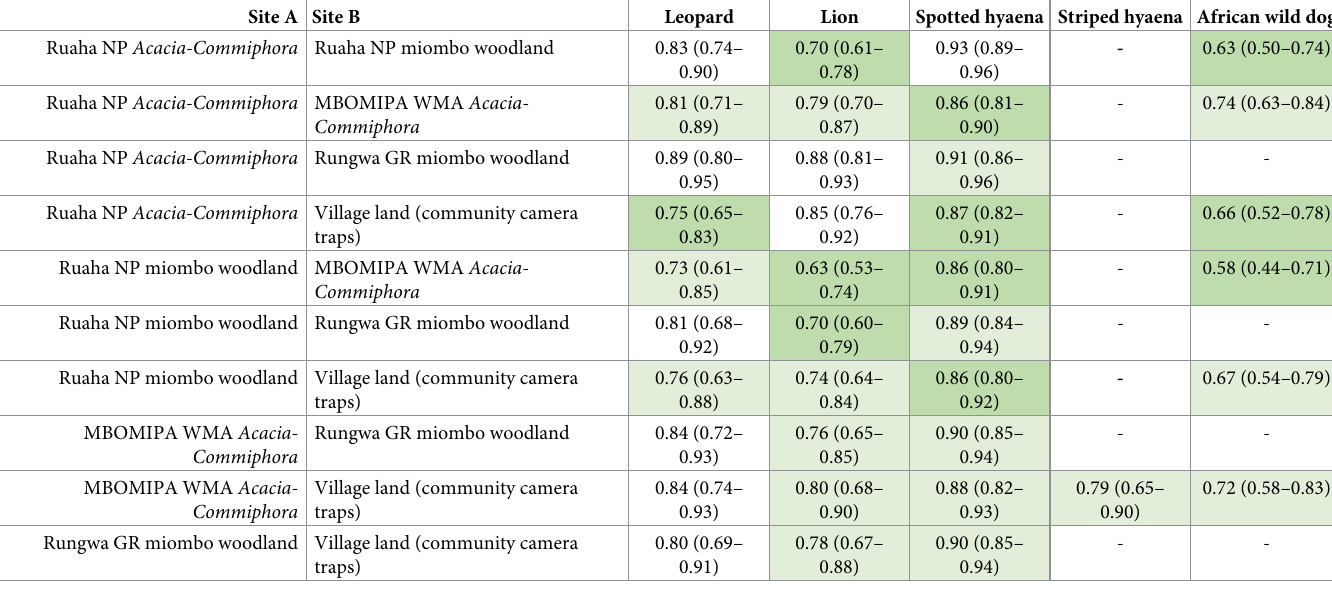
Table 2. Coefficients of overlap ( Δ ) for each large carnivore species between the different survey sites.